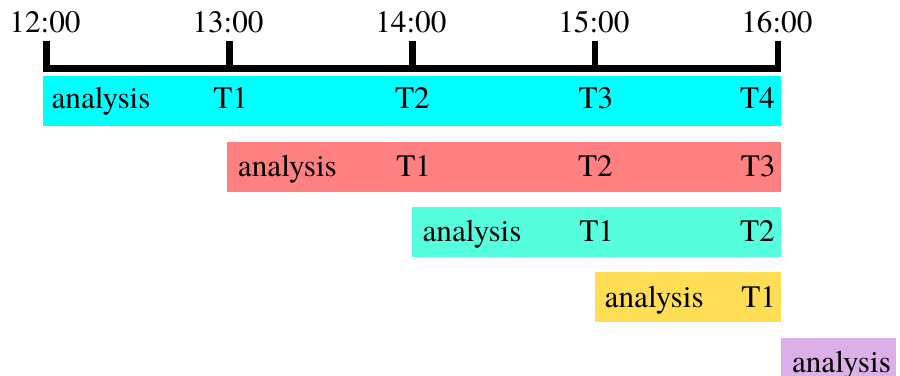
Figure 3. The forecast error at each hour is computed using a triangular scheme and the analysis from subsequent forecast times as “truth.” For instance, the one-hour forecast error for the 12:00 UTC forecast is the value of the desired fields from the 12:00 UTC T1 step minus the analysis value from the 13:00 UTC